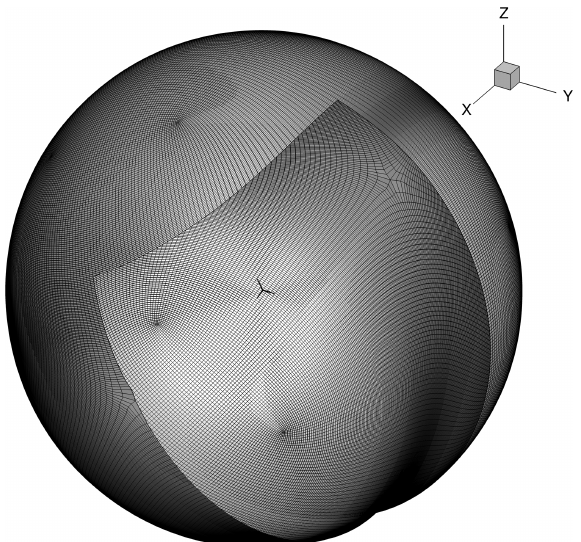
Figure 3. The baseline wind turbine design with the spherical L0 mesh around it. The blade span is 89.166m, and the spherical mesh stretches to 20 times the blade span.